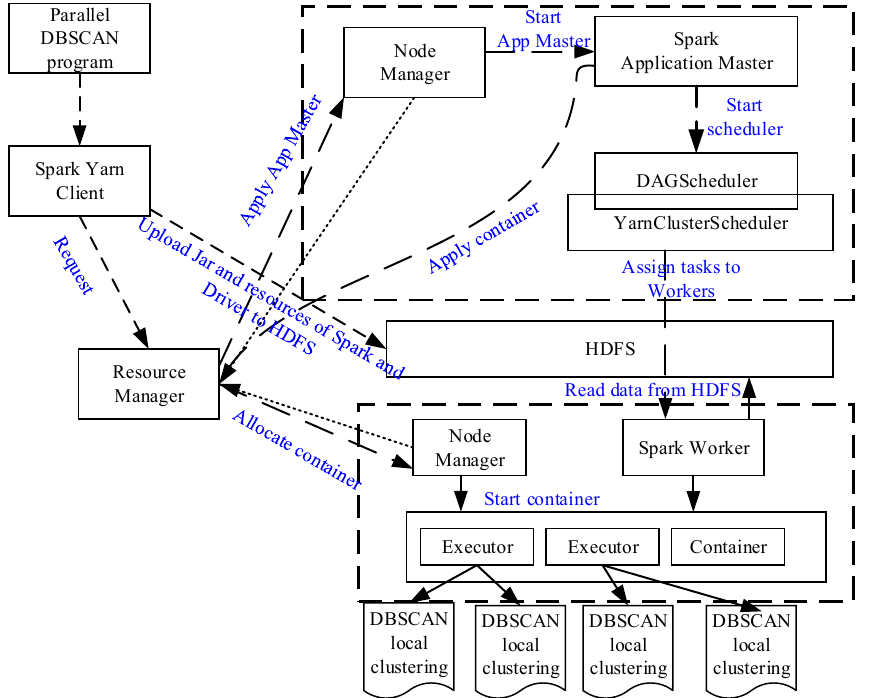
Figure 15. Parallel DBSCAN algorithm based on Yarn resource manager.